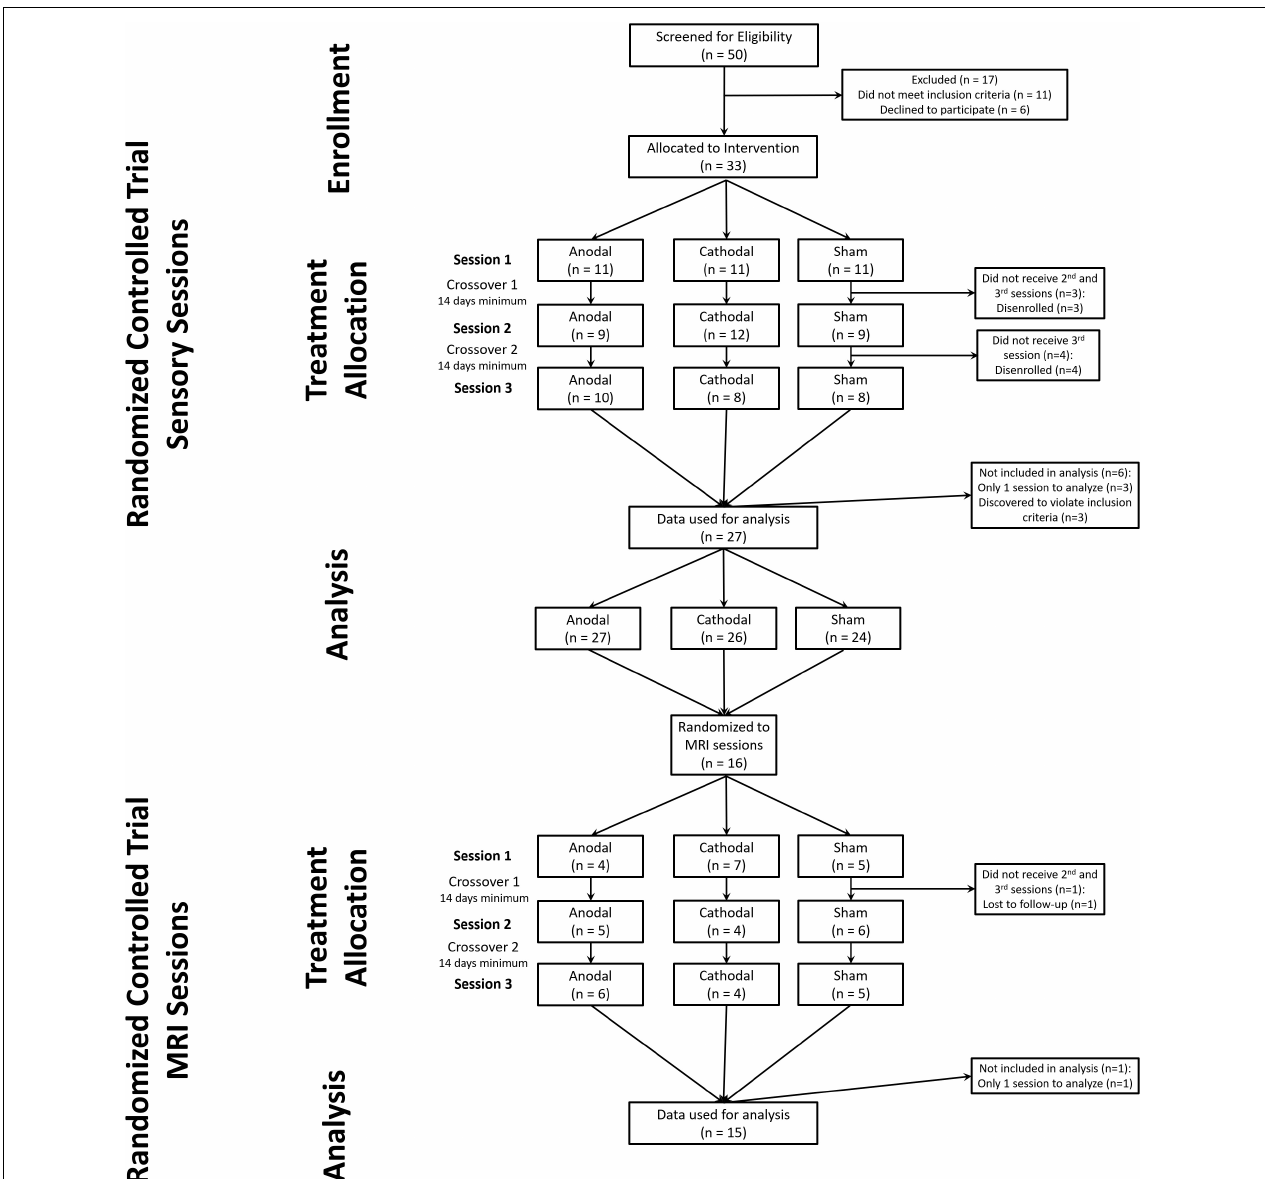
FIGURE 1 | CONSORT diagram for study. We screened 50 potential subjects of which 33 were allocated to a randomized intervention. During the study 6 subjects failed to maintain eligibility or were lost to follow-up. After one MRI session with sham tDCS one subject was lost to